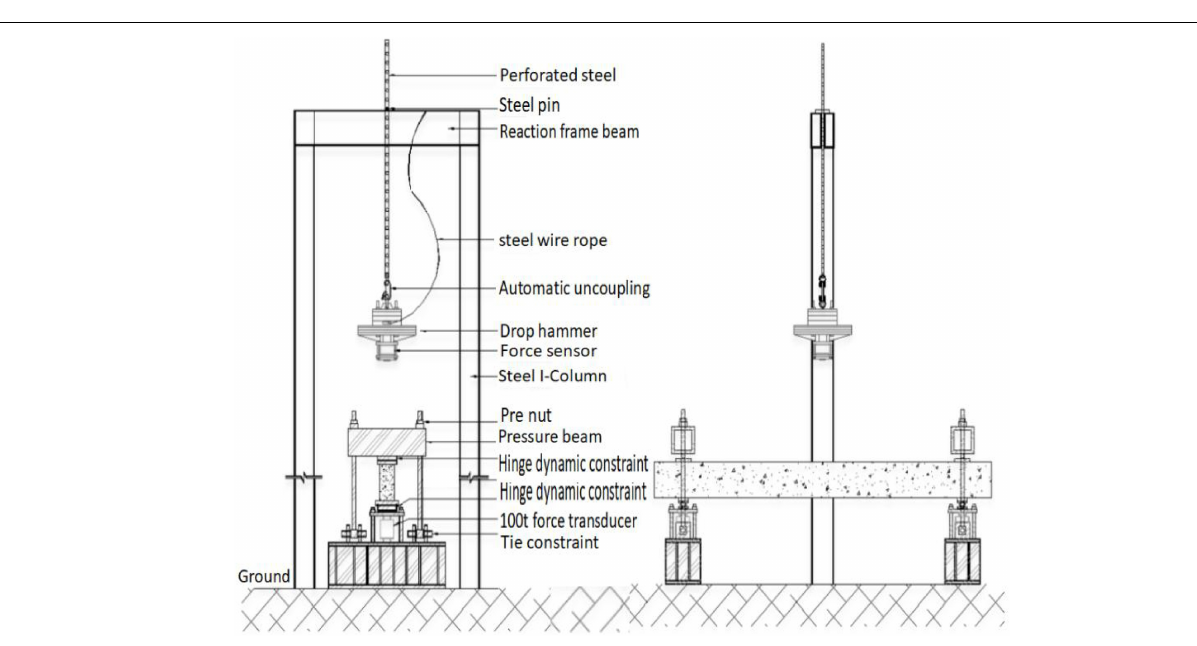
FIGURE 1 | Specimen size and reinforcement (unit: mm).